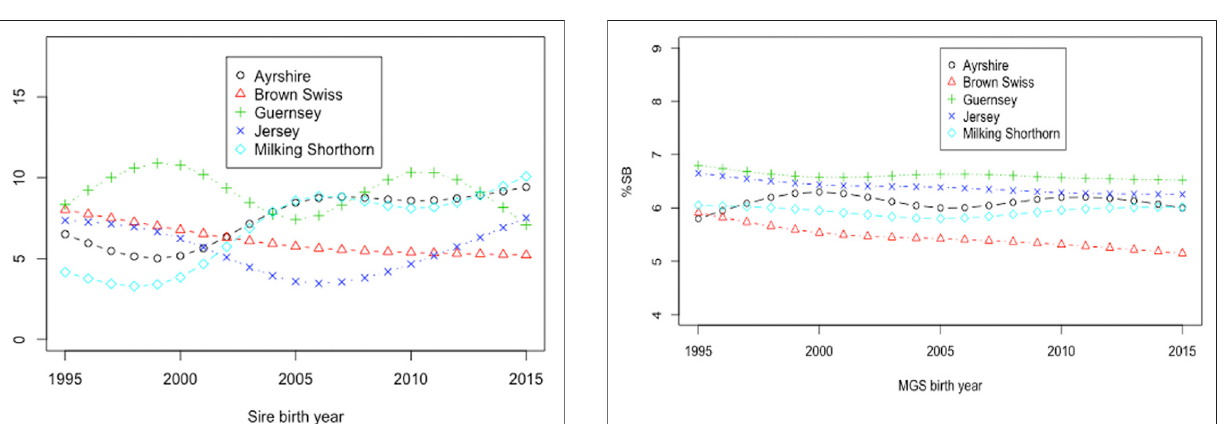
FIGURE 6 | Smoothing spline plots of mean daughter PTA for the percentage of stillbirths (%SB) by maternal grand-sire (MGS) birth year since 1995 in fi ve non-Holstein dairy